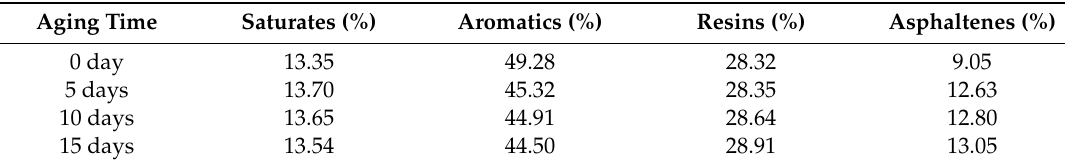
Table 5. ZH-70 linear-modified asphalt composition. Table 4. ZH-70 base asphalt composition.